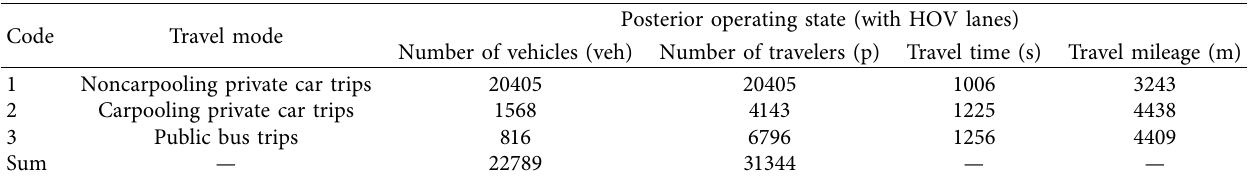
Table 14: Travel time and travel mileage of different travel modes after travel mode transferring in the posterior operating state (with HOV lanes).